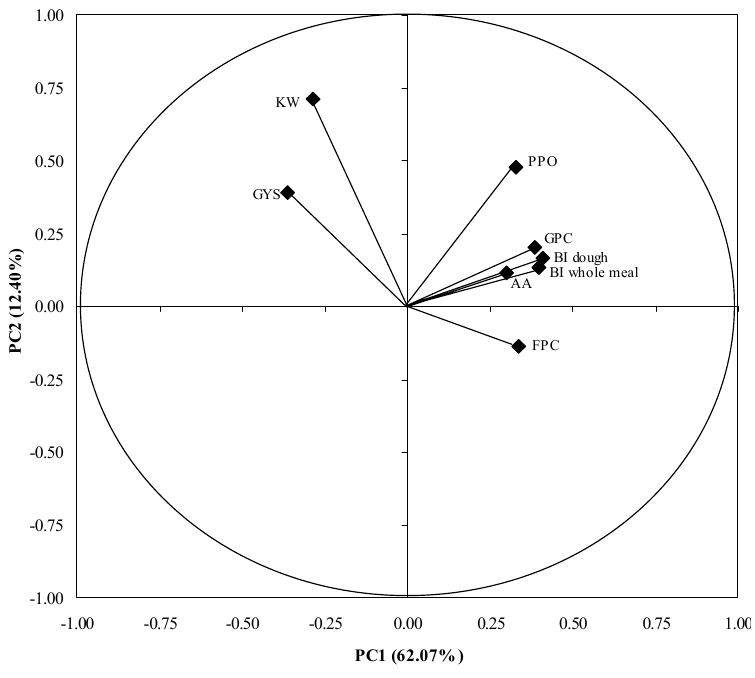
Fig. 2. Variables loading plot for the first two principal components PC1 and PC2 obtained using the analytical data evaluated in a tetraploid wheat collection grown at Valenzano (Bari, Italy) in 2010. TSPC = soluble phenolic compounds; AA = antioxidant activity; GPC = grain protein content; BI = brown index; KW = thousand-kernels weight; GYS = grain yield per spike.